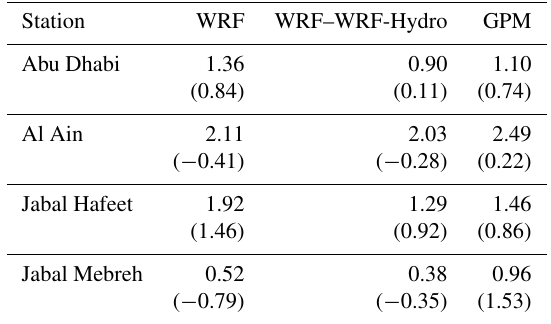
Table 3. RMSE (rBIAS) of simulated and retrieved rainfall at Abu Dhabi, Al Ain, Jabal Hafeet, and Jabal Mebreh stations for 30min intervals ( n =